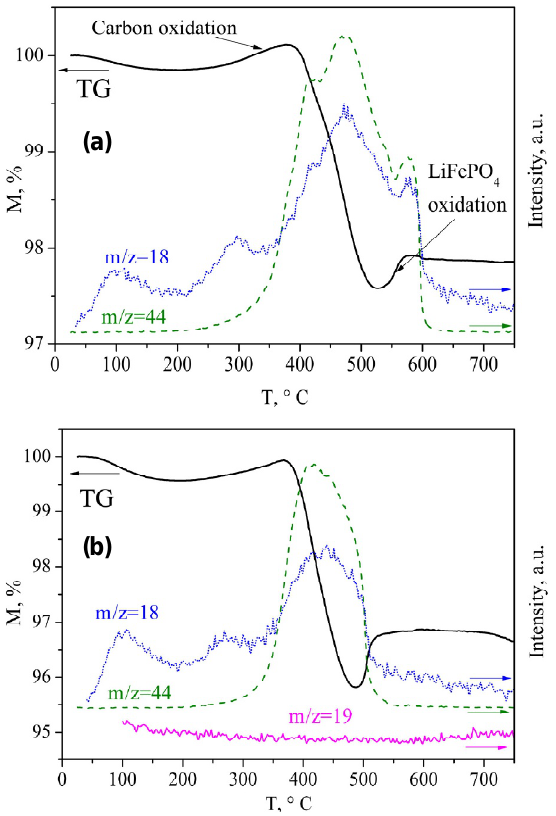
Fig. 4. Thermogravimetric curves (TG) and intensities of evolved gas flow versus temperature obtained for LFP/C-PVA-600-{II} (a), LFP/C-PVDF-600-{II} (b) and LFP/C-PVDF-800-{II} (c). The numbers adjacent to curves indicate mass numbers (m/z) for respective